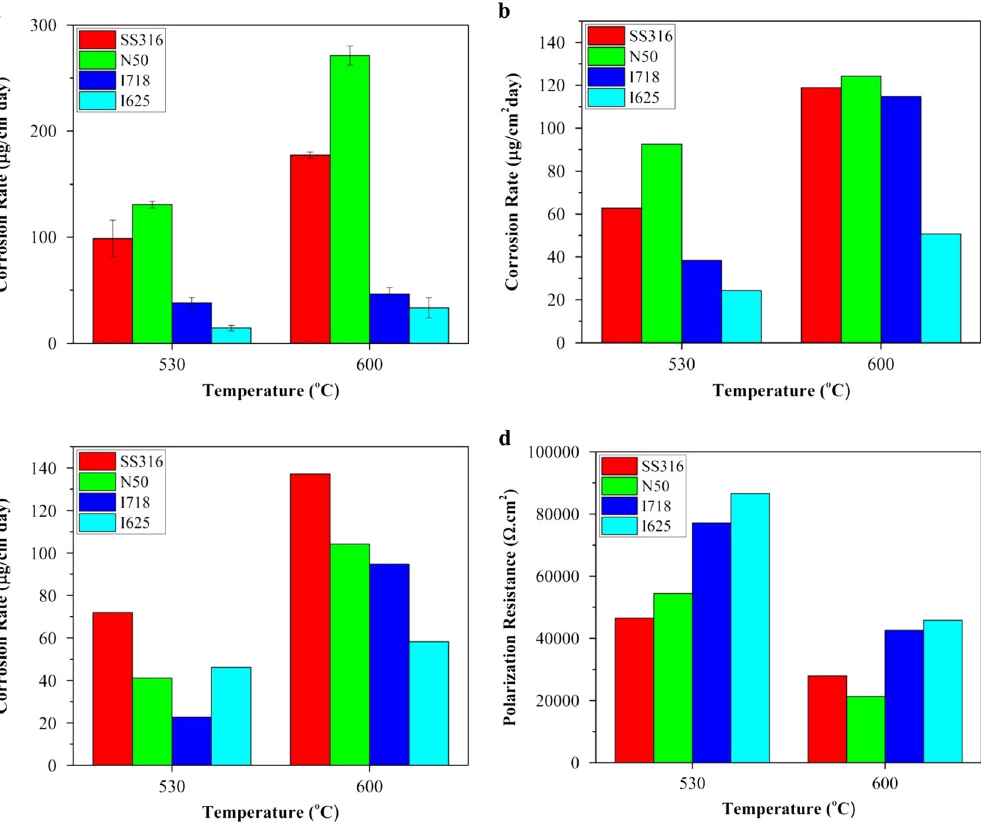
Fig. 3 Quanti fi cation of corrosion behavior: Summary of a corrosion rates calculated from exposure testing, b corrosion rates calculated from electrochemical frequency modulation, c corrosion rates calculated from electrochemical impedance spectroscopy, d polarization resistance values from electrochemical impedance spectroscopy for SS316, N50, I718 and I625 exposed to supercritical water at 530 °C and ultra- supercritical water at 600 °C